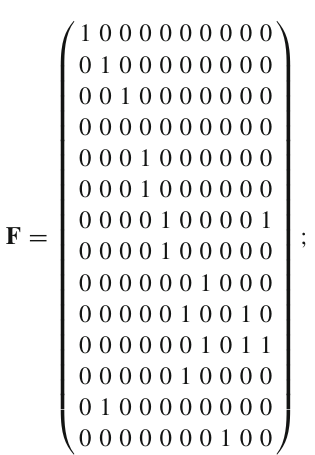
Fig. 4 The PN model of the system with the failure represented by t f